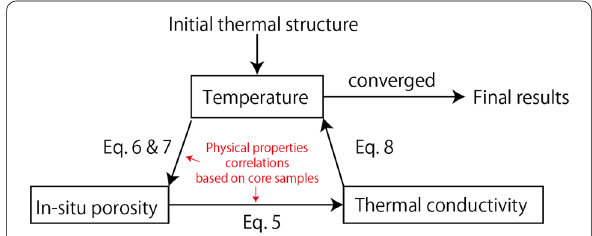
Fig. 2 Schematic diagram of iterative estimations for in situ porosity and thermal